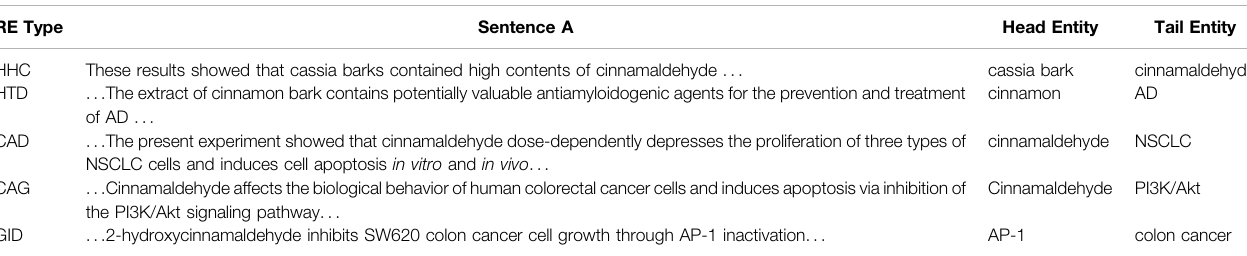
TABLE 2 | Instances in the herb RE